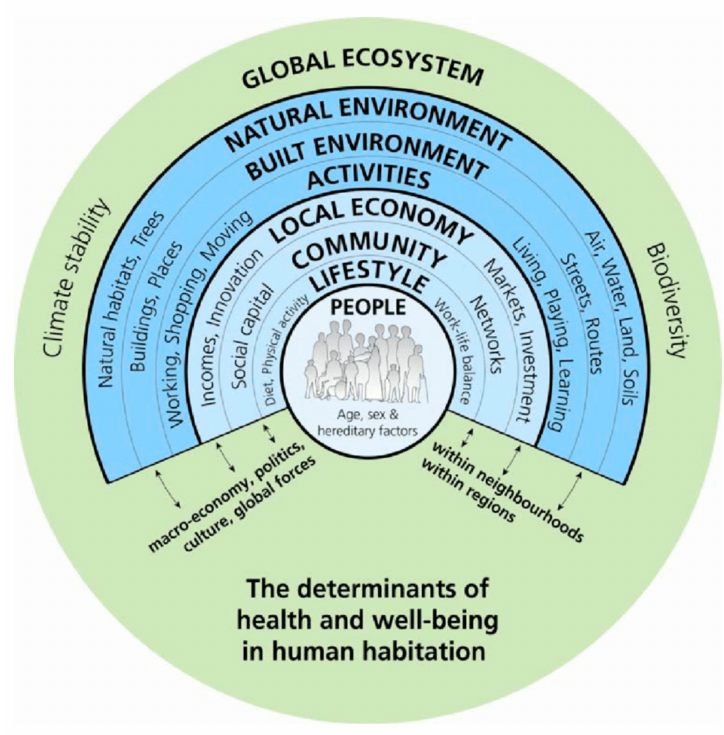
Figure 1. The Settlement Health Map. Source: Barton & Grant, 2006